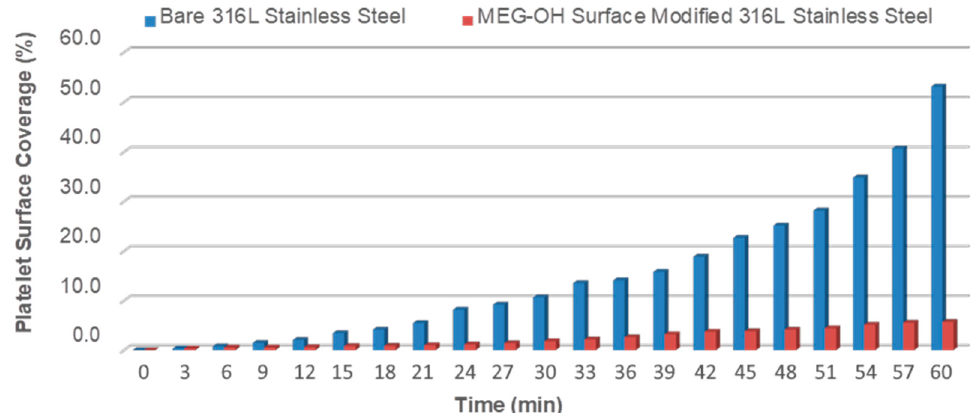
Figure 7. Real-time platelet surface percentage coverage on bare and MEG-OH-modified 316L stainless steel during 60 min of blood perfusion at 100 s − 1 shear rate.